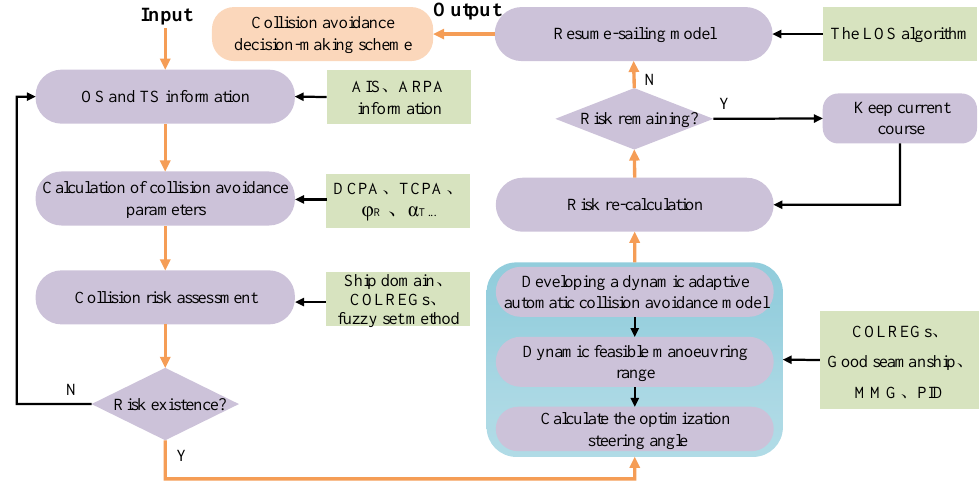
Figure 1. The framework of decision support methodology for autonomous collision avoidance.